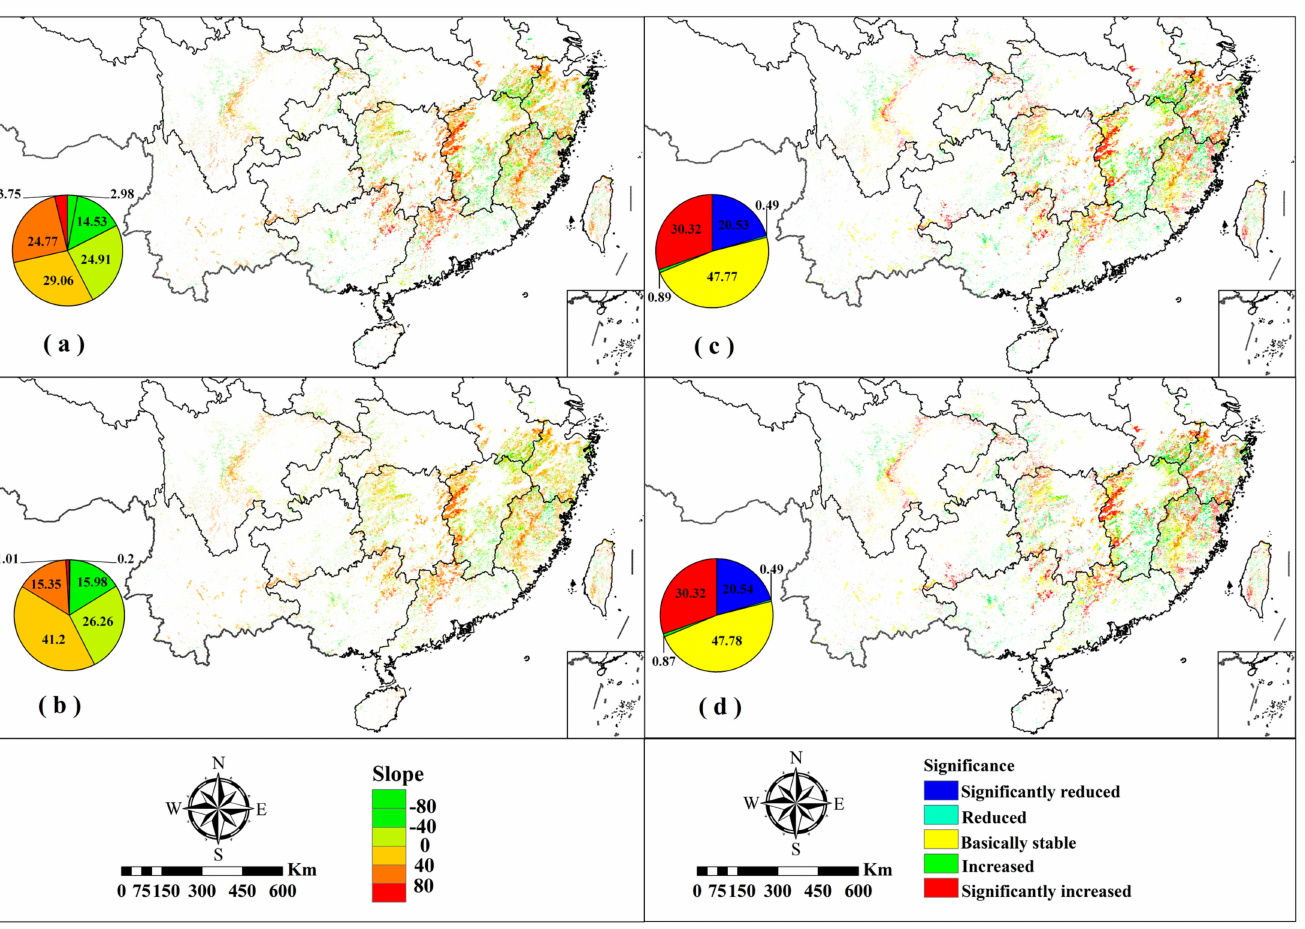
Figure 8. Spatial distribution of trend changes in ( a ) GPP and ( b ) NPP, significant changes in the ( c ) GPP and ( d ) NPP of bamboo forests in China from 2001 to